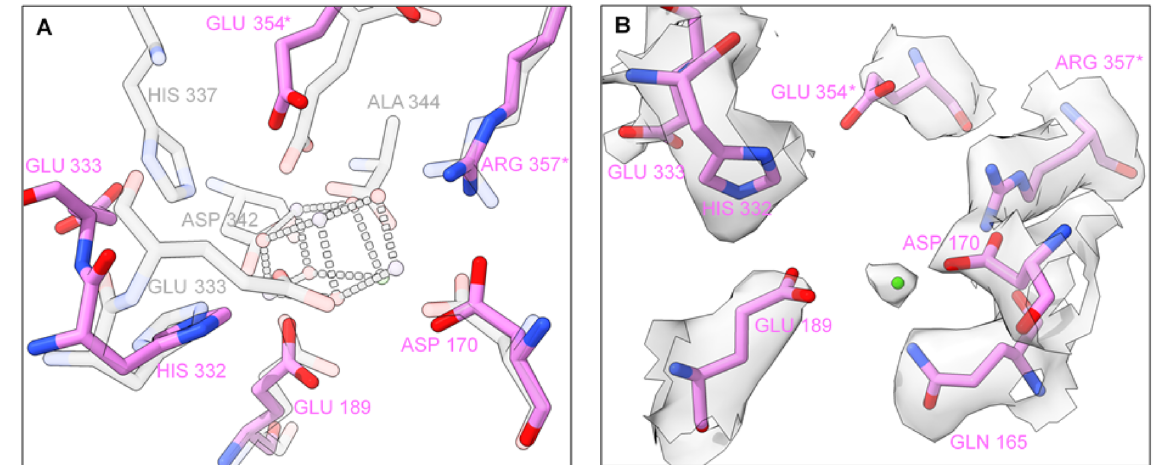
Figure 6. The manganese cluster binding site. ( A ) Amino acid ligands to Mn4CaO5: Spinach PSII (3JCU, transparent grey) superimposed to Arabidopsis PSII (7OUI, pink). To avoid double labelling, the overlapping residues of 3JCU are not identified for clarity. ( B ) Arabidopsis amino acid ligands to Mn4CaO5 fit into their respective densities and an extra density attributed to a positive metal ion (in our structure modelled as manganese). *Identifies the amino acids belonging to the CP43 protein, while the remaining apply to the D1